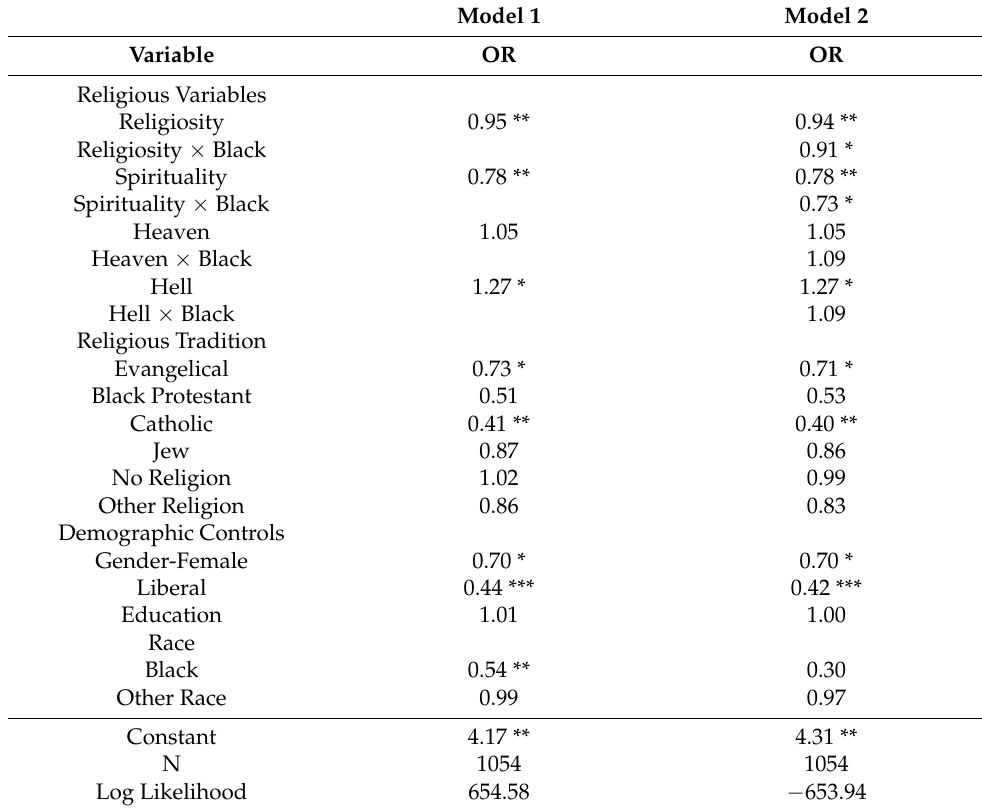
Table 2. Results from binary logistic regression on support for the death